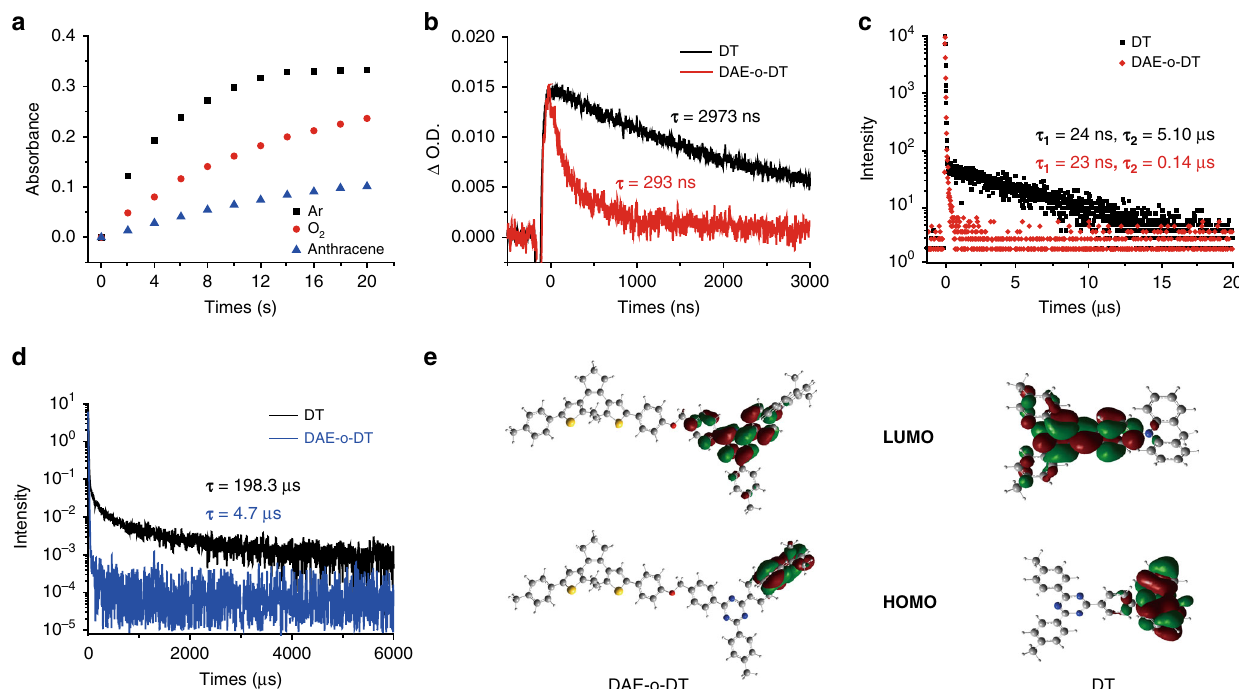
Fig. 3 The mechanism investigation of visible-light-driven DAE-o-DT. a Photocyclization performances of DAE-DT (2.0 × 10 − 5 M) in argon bubbling toluene (black square), oxygen bubbling toluene (red circle) and toluene with triplet quencher anthracenes (1.0 mM, blue triangle), respectively. b Transient absorption decays of DT (1.0 × 10 − 4 M) and DAE-o-DT (1.0 × 10 − 4 M) at 620 nm. c The luminescence lifetime spectra of DT (2.5 × 10 − 4 M) and DAE-o-DT (2.5 × 10 − 4 M) at 495nm. d The emission decays of DT (2.5 × 10 − 4 M) and DAE-o-DT (2.5 × 10 − 4 M) at 77 K in toluene. e